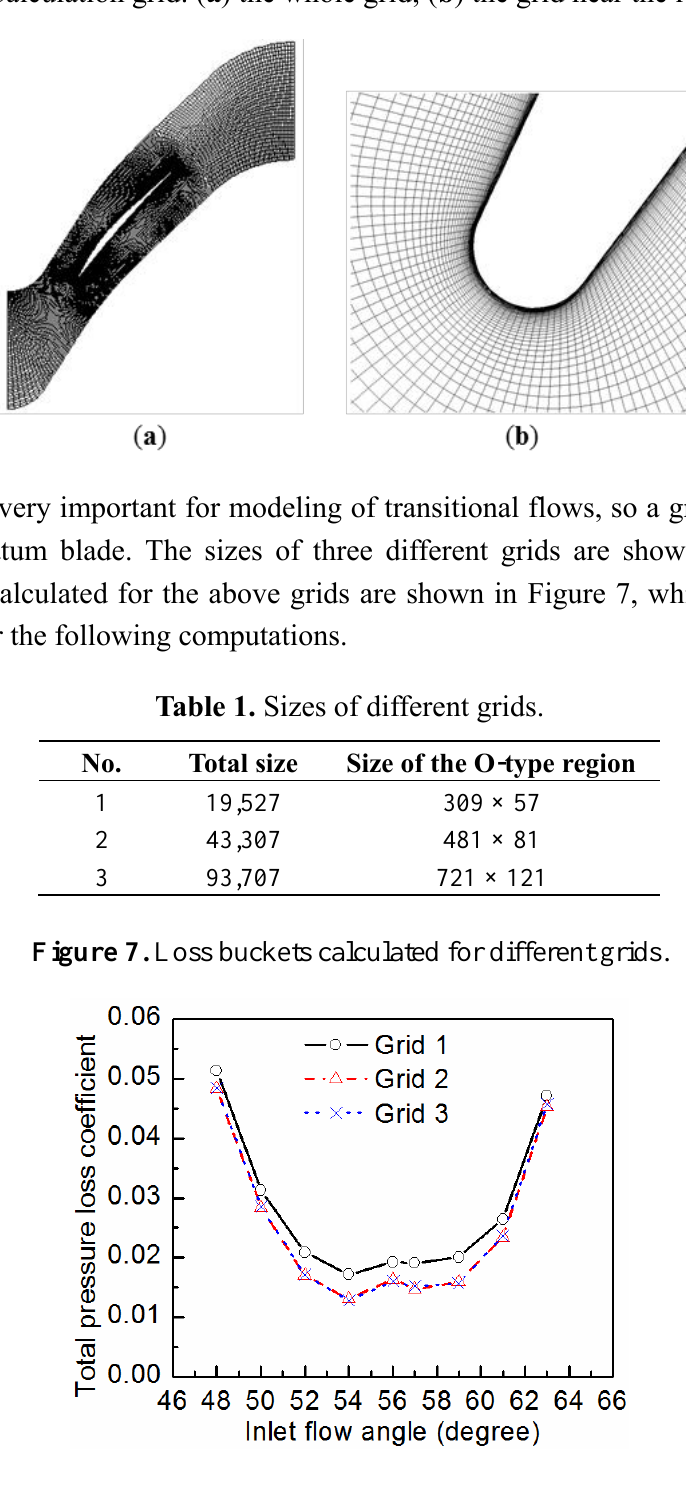
Figure 6. Calculation grid: ( a ) the whole grid; ( b ) the grid near the leading edge.